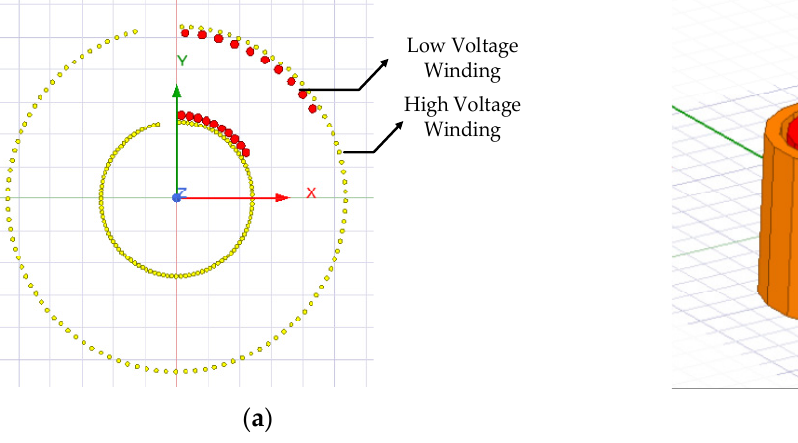
Figure 4. Winding Design: ( a ) Toroidal Winding ( b ) Shell Type Winding.